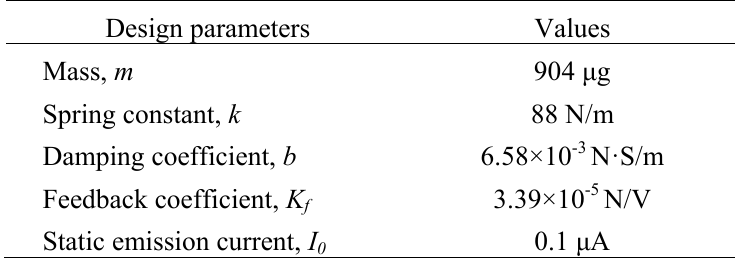
Table 1. Design parameters of vacuum microelectronic accelerometer.